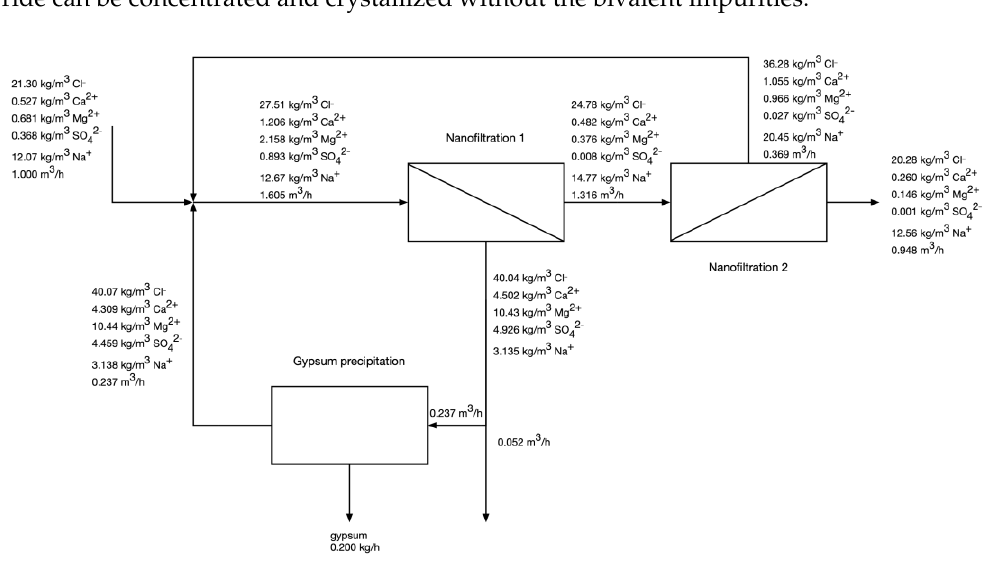
Figure 3. Calculated compositions of process streams in RO-evaporator-crystallizer if no NF pre- treatment is used. 3.3.2. Projected Operation after NF Pretreatment Figure 4 presents the composition of process streams in the RO-evaporator-crystal- lizer part when NF pretreatment is applied. The results show that the application of two- pass NF with intermediate gypsum precipitation increases the salt recovery – 26.7 kg/h of